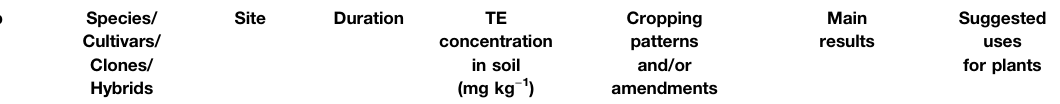
TABLE 4 | ( Continued ) Examples of fi eld trials with economically valuable crops under different cropping patterns and/or amendments